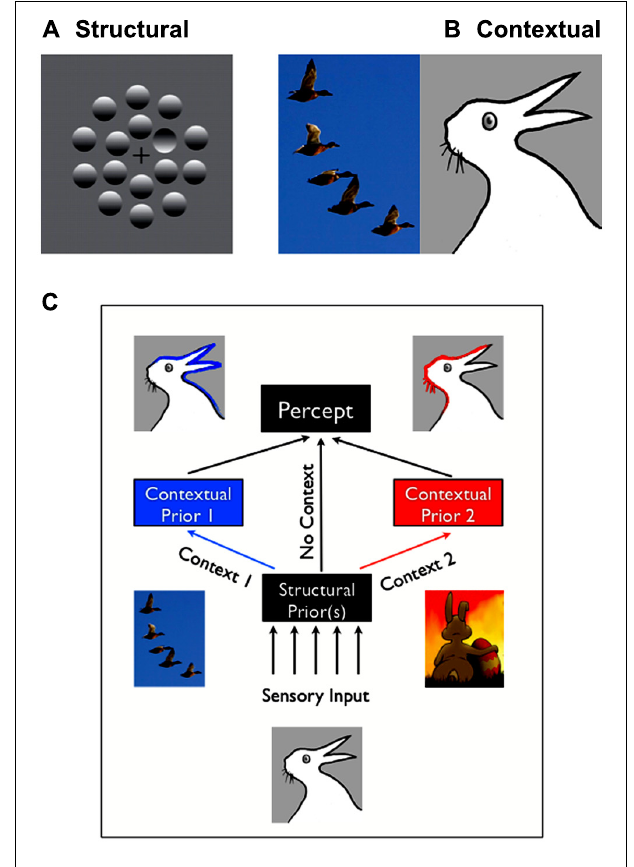
FIGURE 1 | Structural vs. contextual expectations. (A) Example of a structural expectation: the “light-from-above” prior. Are those shapes bumps or dimples? Perceiving one dimple in the middle of bumps is consistent with assuming that light comes from the top of the image. Turning the page upside down would lead to the opposite percept (seeing a bump in a middle of dimples). (B) Example of a contextual expectation. What do you see in the drawing on the right: a rabbit or duck?This ambiguous and bistable percept can be influenced by the spatial context in which it is placed, for, e.g., having just seen a flock of ducks would make one more likely the perceive a duck. (C) Structural expectations act as “default” expectations, but can be superseded by contextual